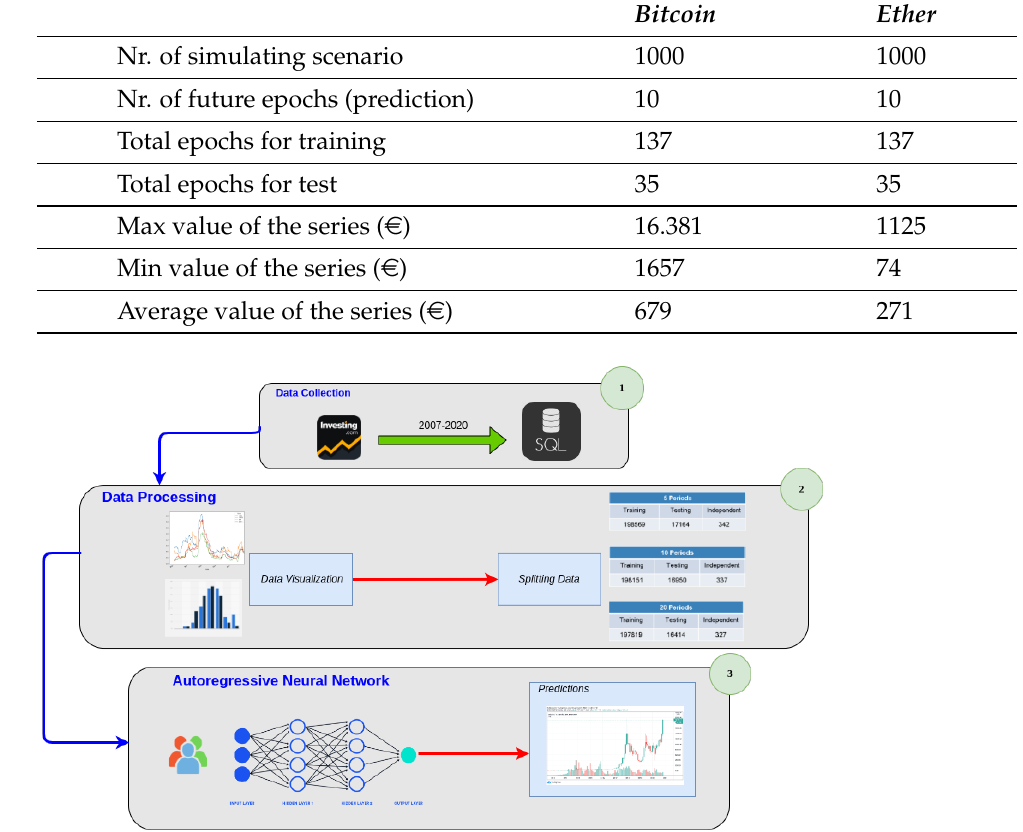
Figure 1. The figure shows the different components of the Crypto Net